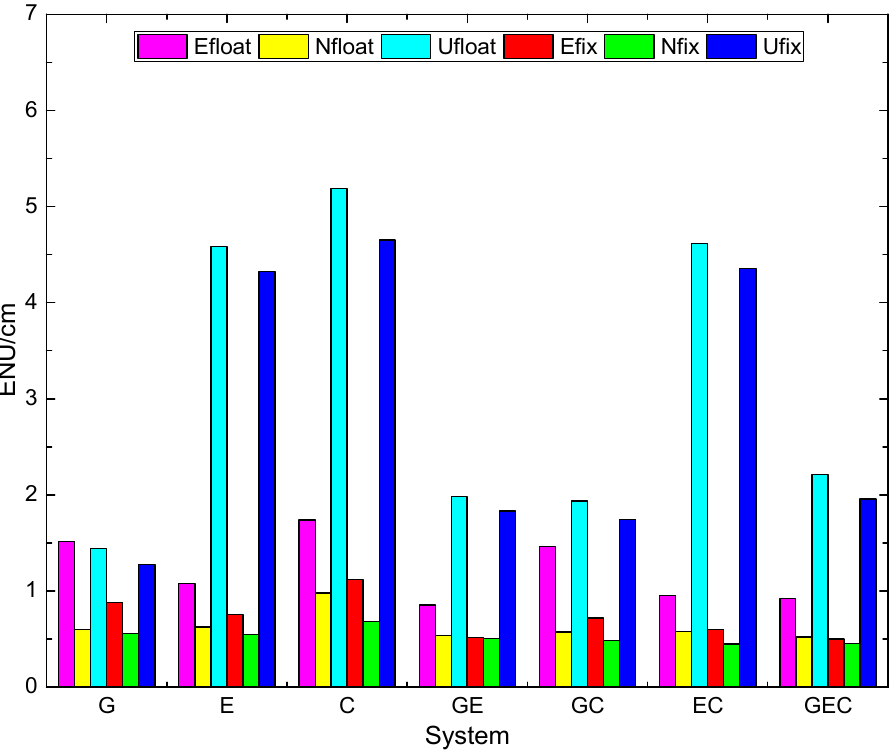
Figure 14. The average RMS of float and fixed PPP solution for seven systems from DOY 321 to 350, 2018. Table 1. The average RMS of float and fixed PPP solution for seven systems (unit: cm).